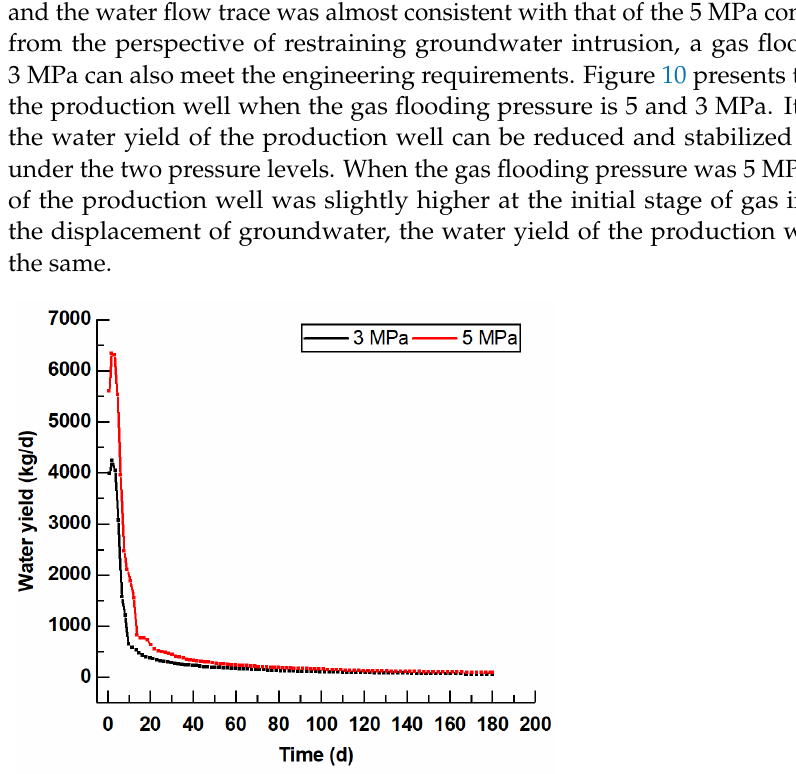
Figure 9. Pressure nephograms when the gas flooding pressure is 5 and 3 MPa, respectively.